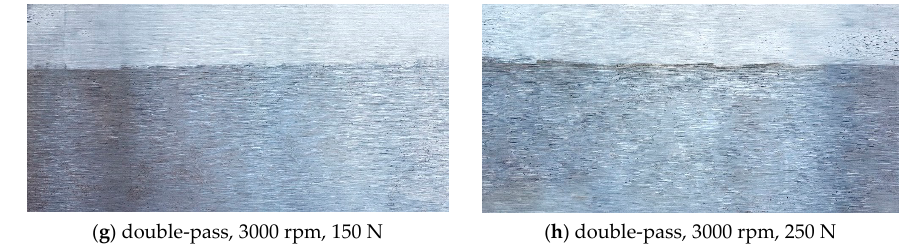
Figure 8. Experimental samples using different process parameters.